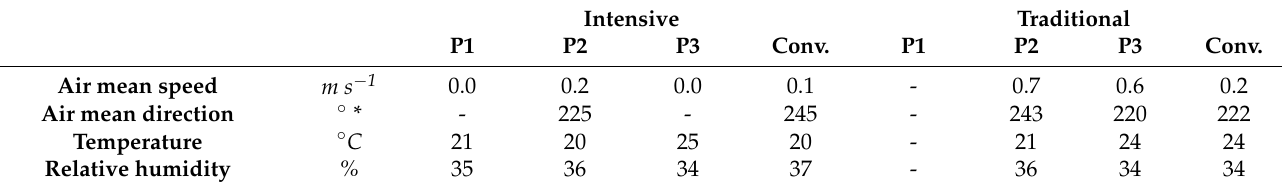
Table 4. Weather conditions during the trials.